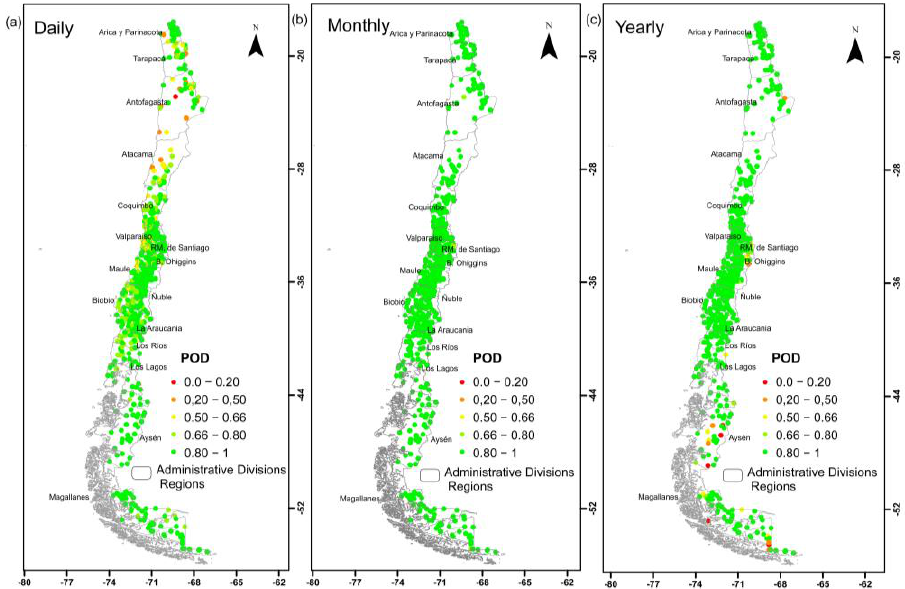
Figure 7. Daily, Monthly, and Yearly POD for IMERG Early product. Remote Sens. 2023 , 15 , x FOR PEER REVIEW